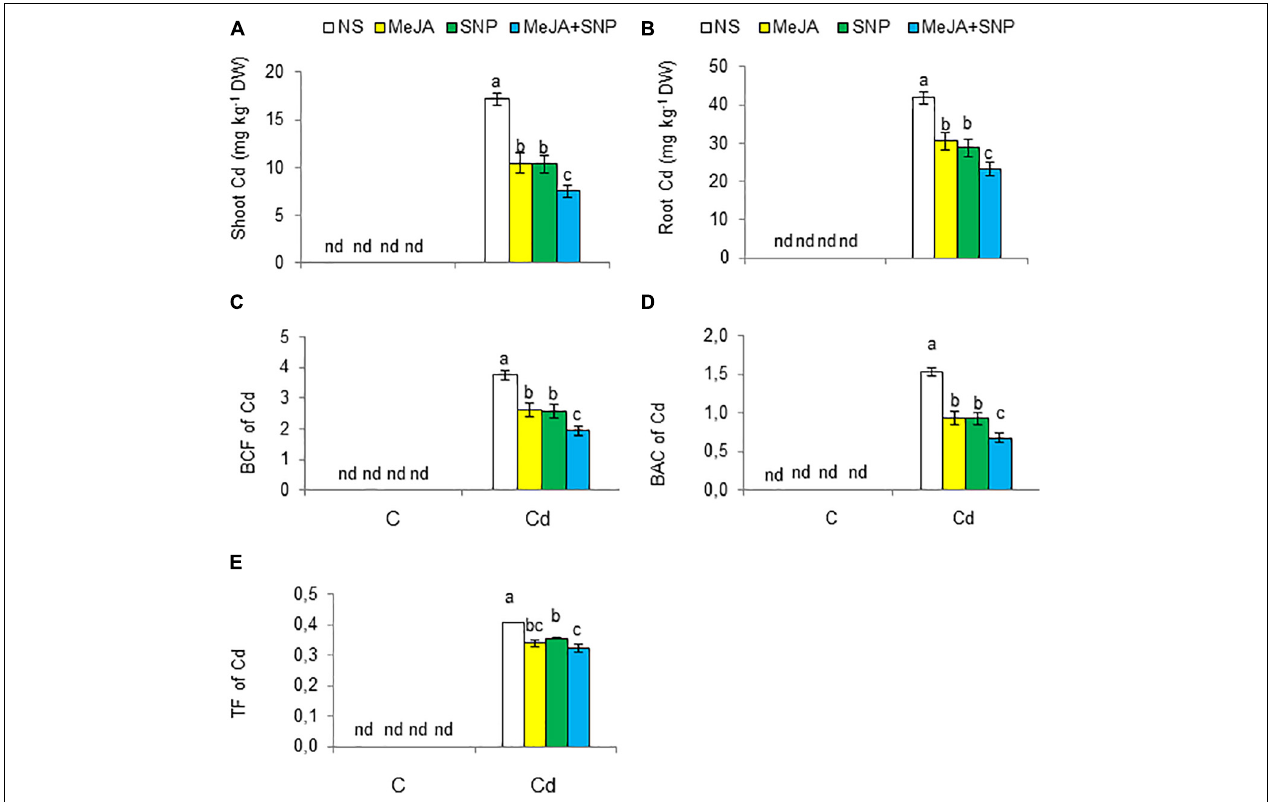
FIGURE 3 | Shoot cadmium [Cd (A) ], root Cd (B) on dry weight (DW) basis, the biological concentration factor [BCF (C) ], biological accumulation coefficient [BAC (D) ], and translocation factor [TF (E) ] of Cd in wheat plants grown under control (C) and cadmium (100 µ M Cd) and sprayed with 10 µ M methyl jasmonate (MeJA) or 100 µ M sodium nitroprusside (SNP) alone or together (mean ± SE). Mean values carrying different letters within each attribute differ significantly ( P ≤ 0.05) based on Duncan multiple-range test. nd, not